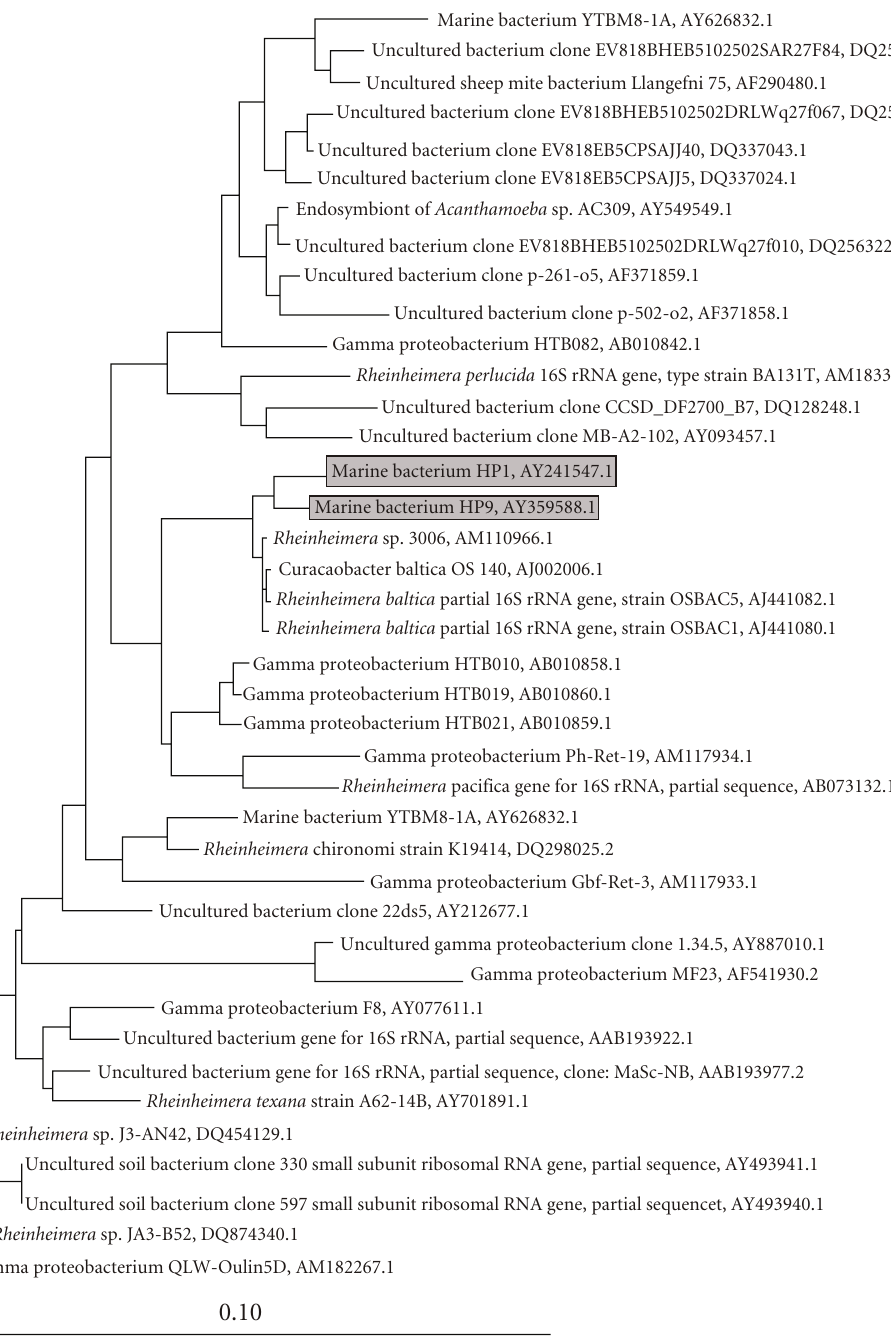
Figure 1: Neighbor-joining tree showing the phylogenetic a ffi liation of strains HP1 and HP9. Selected sequences from the α subclass of Proteobacteria were used to root the tree. The bar indicates 10% sequence divergence.